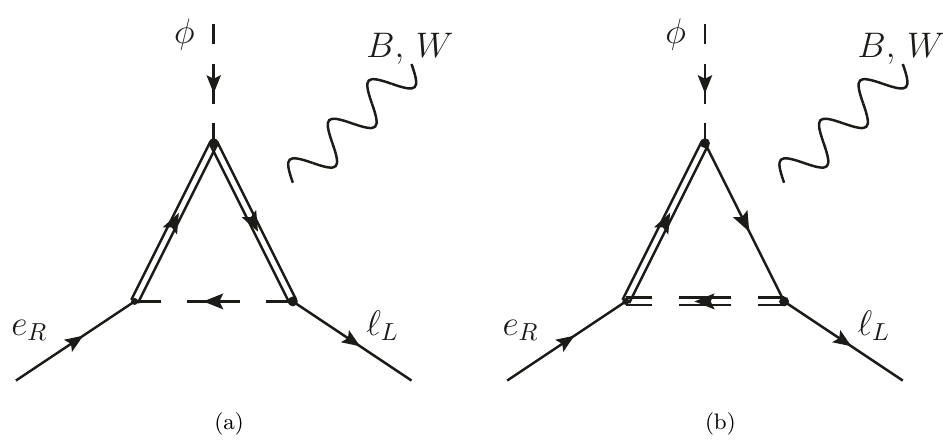
Figure 6 . Left: box diagram contribution to α eγ with 2 heavy fermion propagators. Right: box diagram contribution to α eγ with 1 heavy fermion propagator and 1 heavy scalar propagator. Double lines represent heavy particles whereas single lines are SM particles. The gauge boson ( B or W ) is represented outside the diagram since it can be attached to any of the internal propagators.